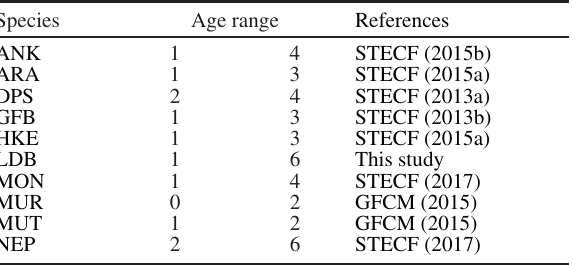
used in the simulations. Species codes as in Table 1. Table 3. – F bar Species Age